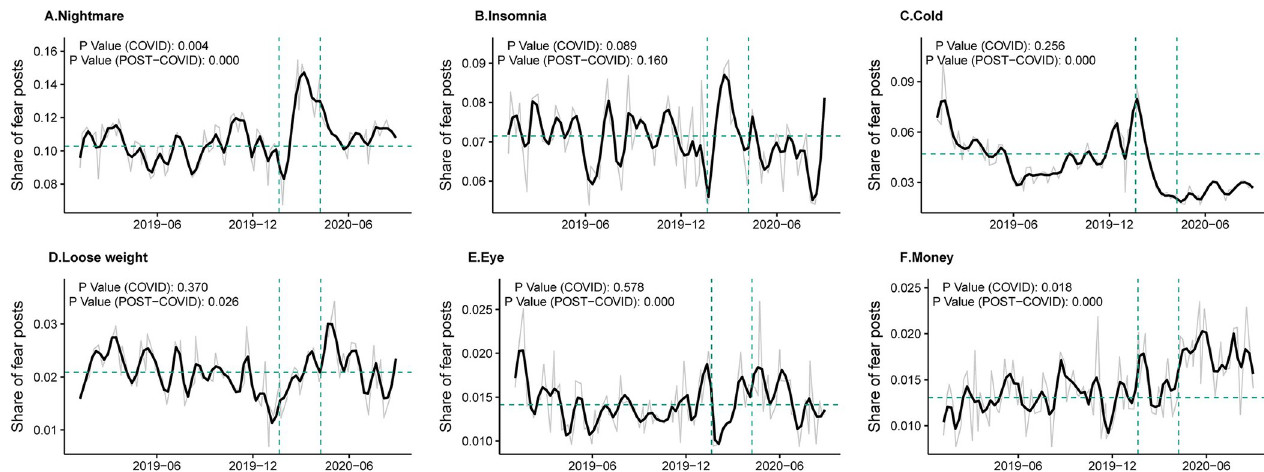
Fig 4. Share of fear posts by topic. Line graphs show the number of posts for six non-COVID-19 related topics by week. The name of each subplot is the most informative word for each topic. The dark solid lines in each subplot display the smoothed number of posts per day. P -value (COVID) and P -value (post- COVID) indicate the t -test results testing the differences of trend between 2020 peak COVID-19/ post-COVID-19 periods with the same period in 2019.